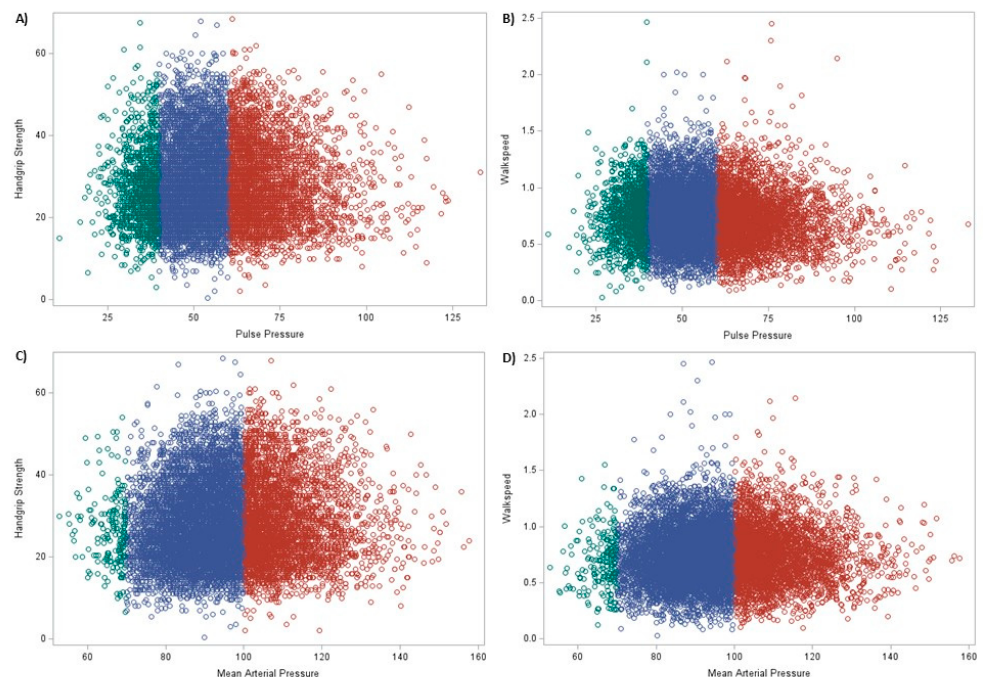
Figure 1. Scatter plots of mean arterial pressure and pulse pressure by handgrip strength and gait speed. Note: ( A ) = pulse pressure and handgrip strength, ( B ) = pulse pressure and gait speed, ( C ) = mean arterial pressure and handgrip strength, ( D ) = mean arterial pressure and gait speed, green = low pulse pressure or mean arterial pressure, blue = normal pulse pressure or mean arterial pressure, and red = high pulse pressure or mean arterial